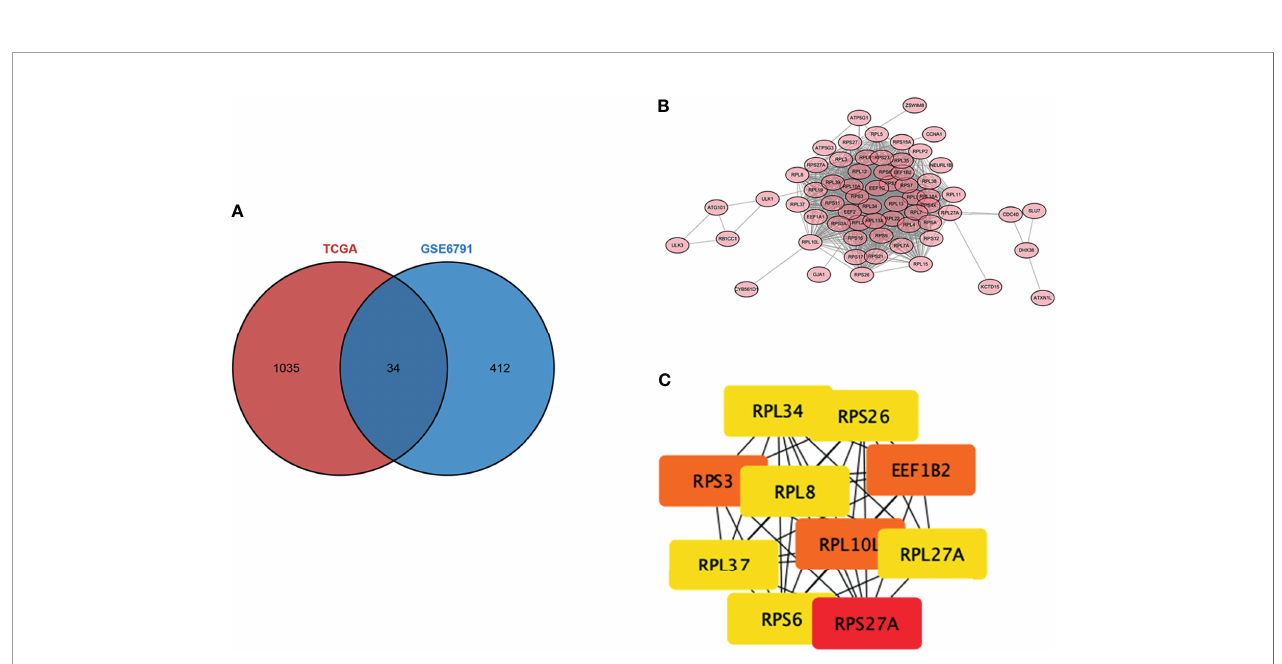
FIGURE 3 | Protein – protein interaction (PPI) network of the differentially expressed genes (DEGs). (A) intersecting genes in TCGA and GSE6791. (B) PPI constructed using the STRING database. (C) Degree ranking of the top 10 potential key genes.